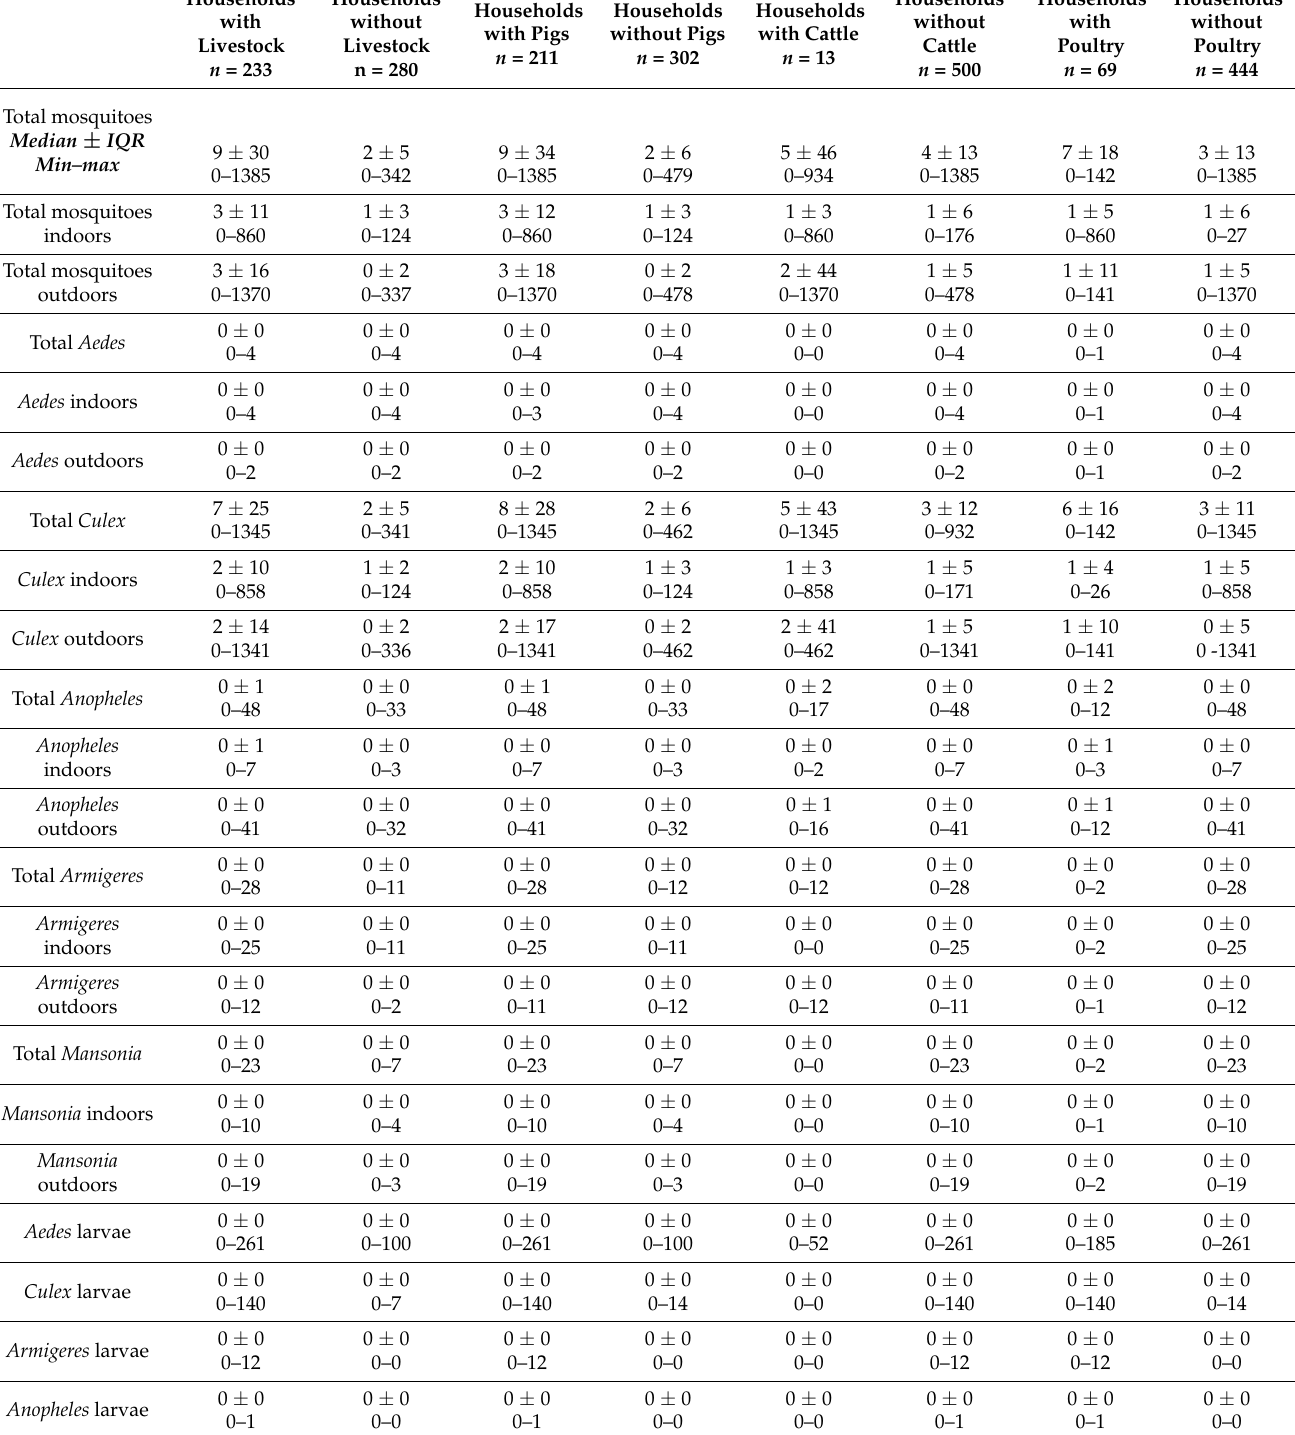
Table 6. Numbers of mosquitoes/larvae in the households in Hanoi